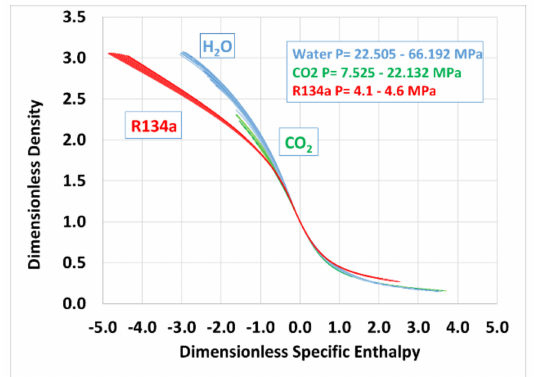
Figure 18. Dimensionless trend of density vs. specific enthalpy for R134a in comparison with water and CO 2